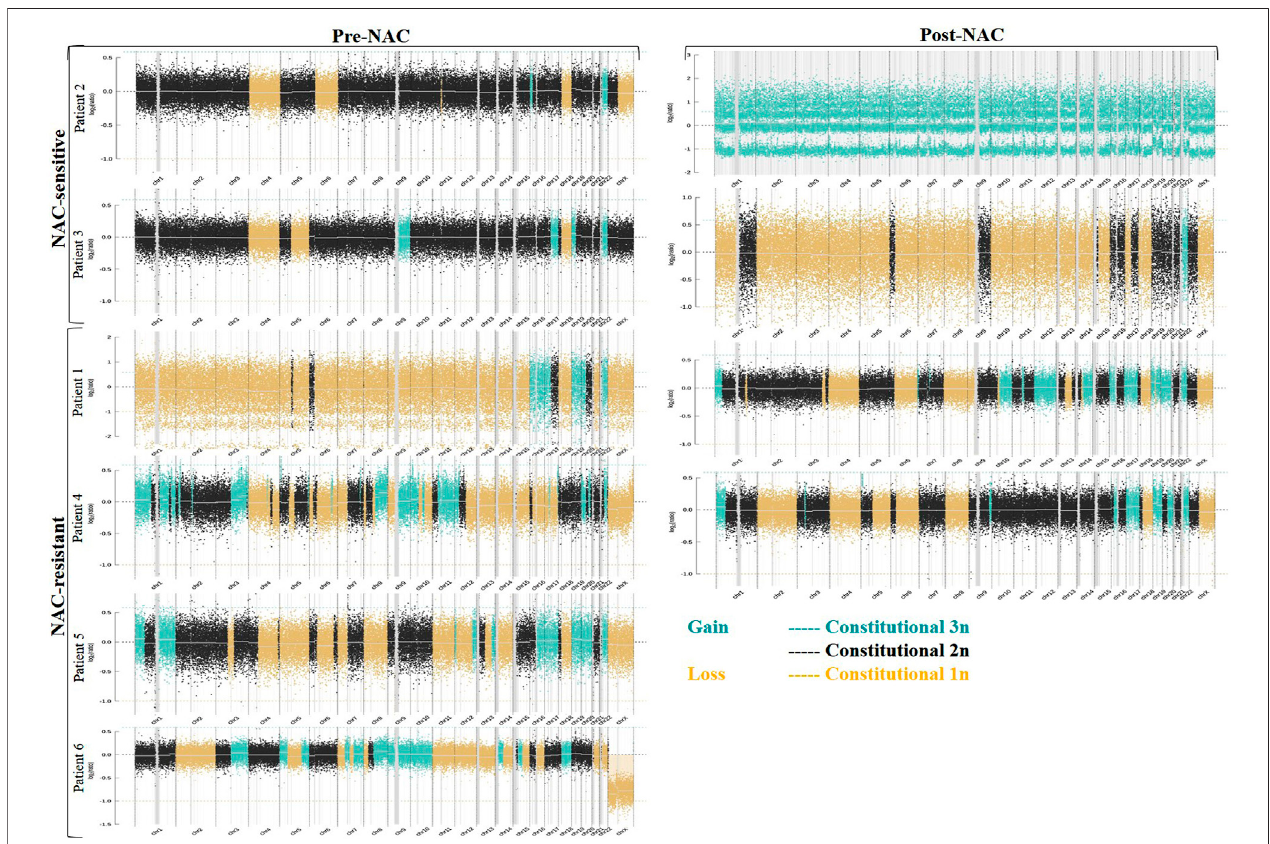
FIGURE1| Copynumbervariations(CNVs)inctDNAfromsixovariancancer(OC)patientsthatweretreatedwithneoadjuvantchemotherapy(NAC).DataCNVsfor all chromosomes based onWISECONDORX analysisweredetected from NAC-sensitive,NAC-resistant, anddead patientgroups. Thecopy numbers weresegmented in blue (gain) and yellow (loss) lines.